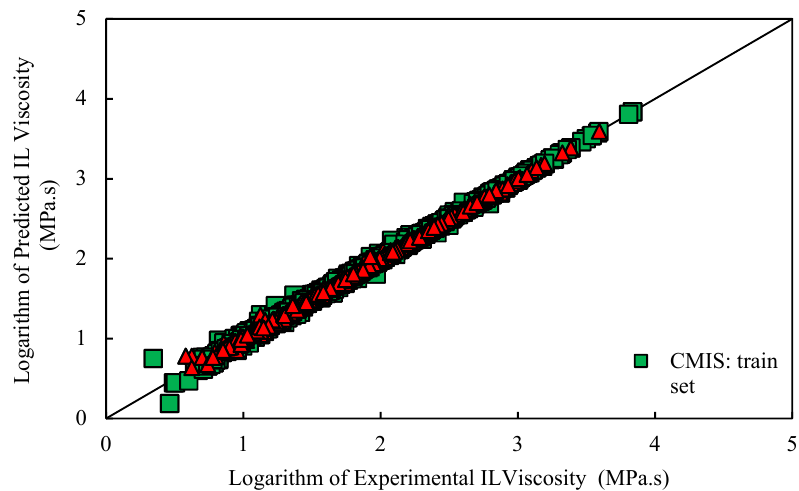
Figure 11. Cross plot of the proposed developed model based on Model (III) for CMIS approach.